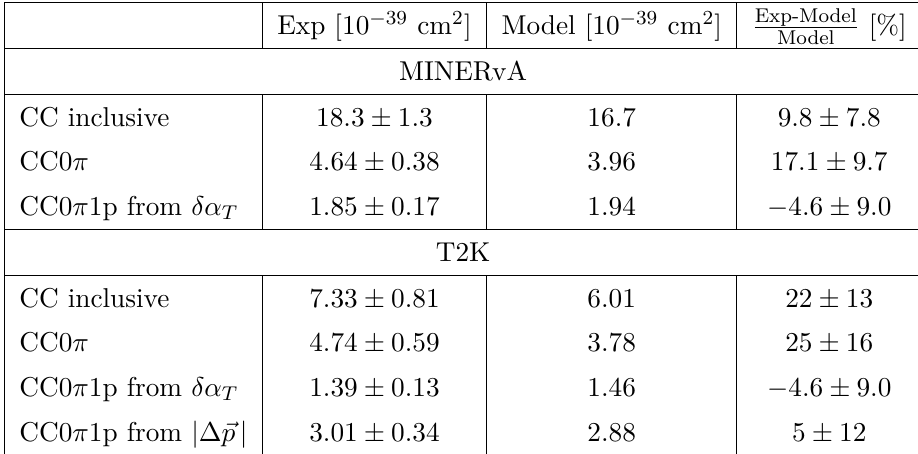
Table 5 . Integrated cross-sections for the different event selections provided by T2K and MIN- ERvA. The CC0 π 1p integrated cross-section has been computed using the dσ/d ( δα distribution for MINERvA and T2K and also dσ/d | ∆ ~p | for T2K. In all cases, the nominal